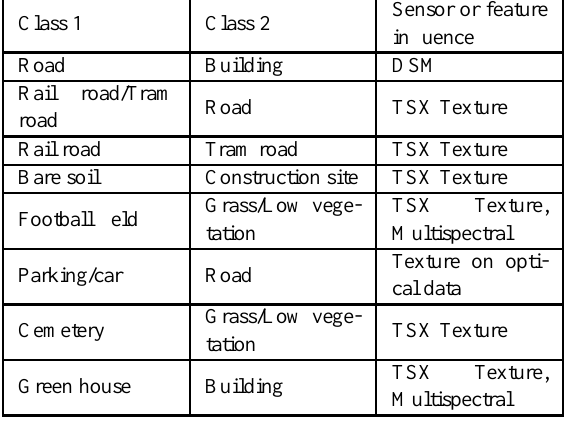
Table 3: Influence of data sources for classification of